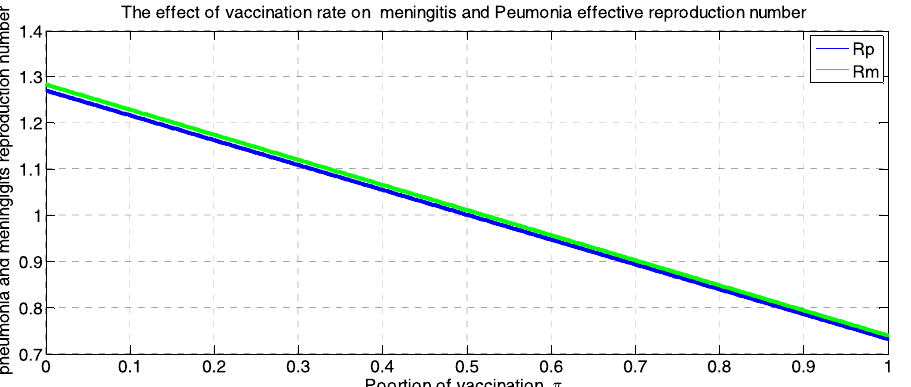
Figure 10. Effect of vaccination rate on meningitis and pneumonia reproduction number.